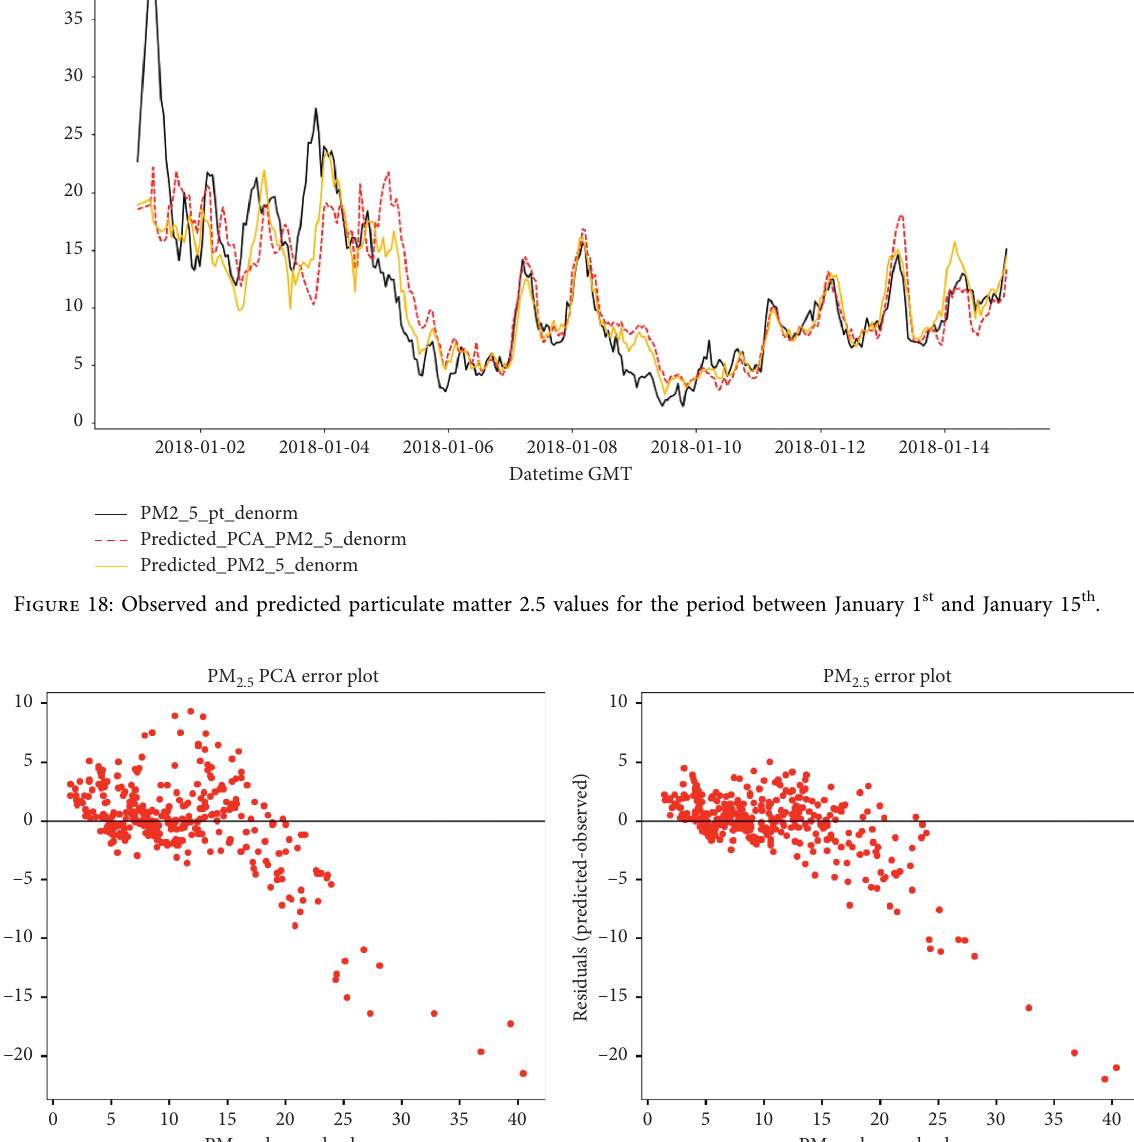
2.5 values and (b) SVR-RBF forecasting errors plotted against